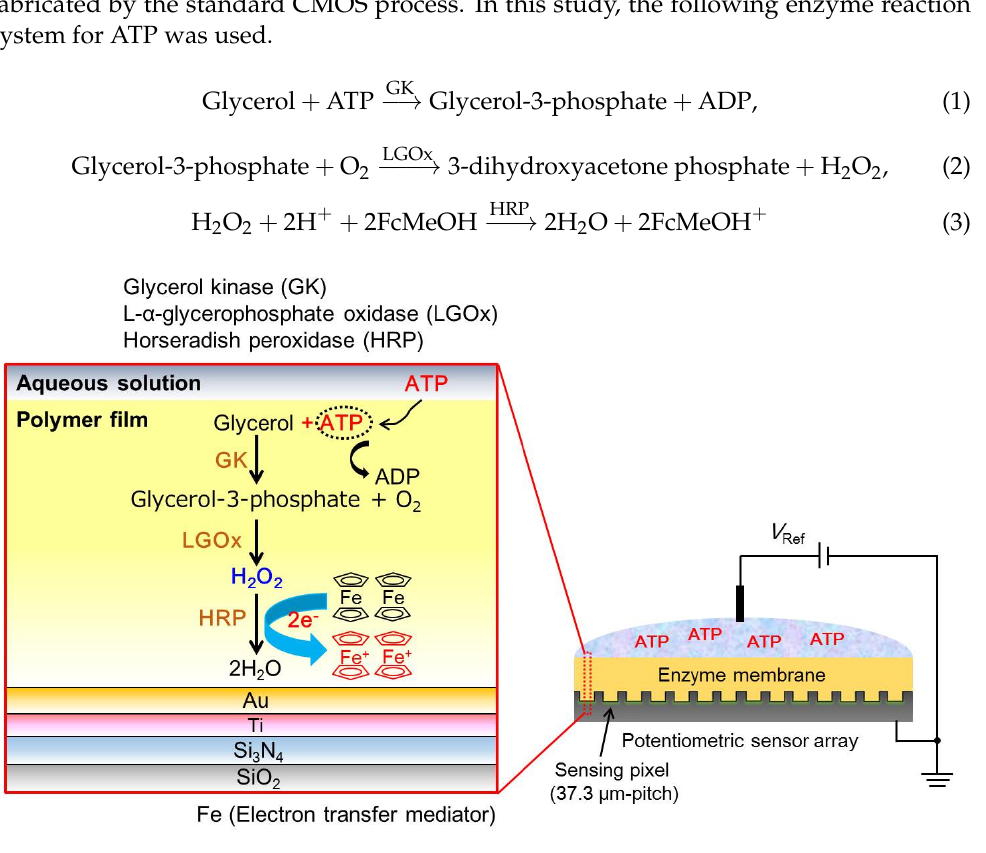
Figure 1. Schematic diagram showing the ATP sensing with redox reaction on a gold electrode. ATP image sensor is fabricated using enzymes GK, LGOx, and HRP entrapped in a polymer